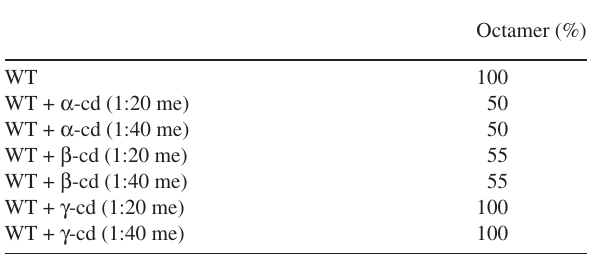
Table 5 . Effects of 1:20 and 1:40 molar excess (me) of α , β and γ cyclodextrins (cd) on the acid pH-induced oligomerization of Sulfolobus solfataricus WT amidase. Results are reported as percent- age of the area corresponding to the octamer in the elution patterns from the PWXL column.